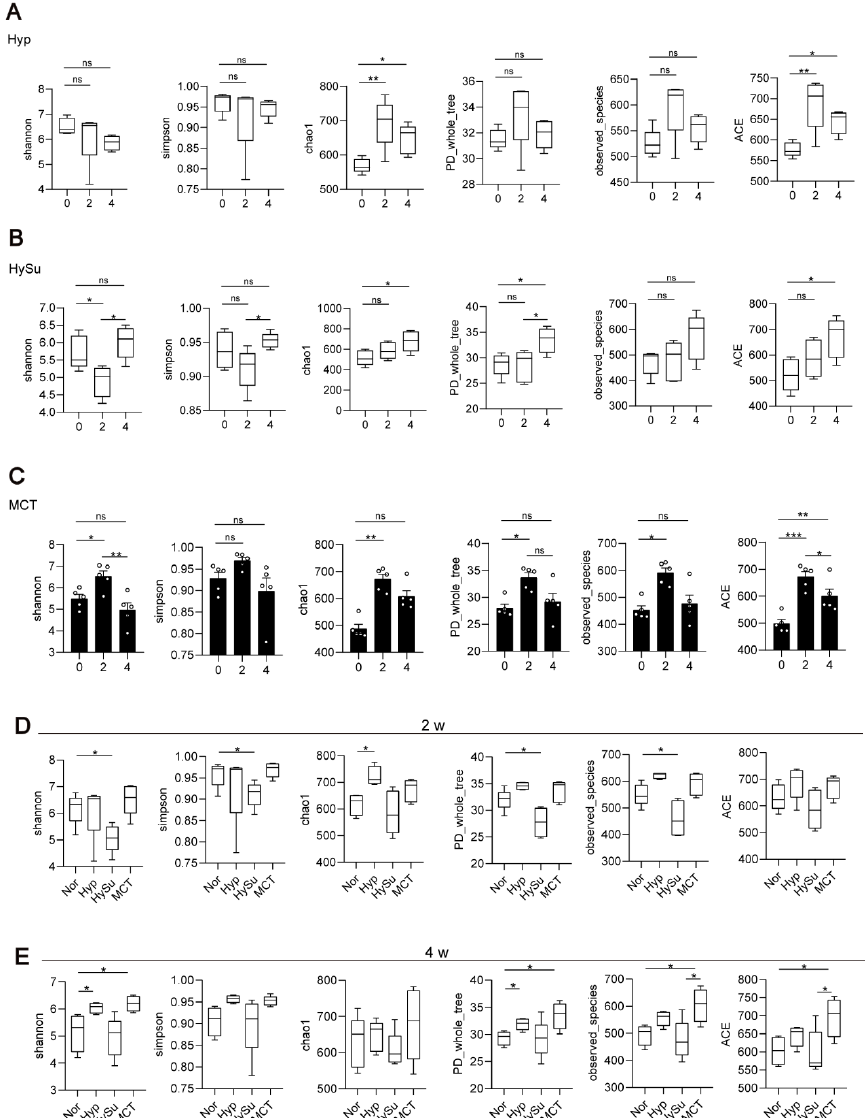
Figure 2. The dynamic α -diversity values and richness indices at week 2 and week 4 in Hyp-, HySu-, and MCT-induced PH rat models. Feces were collected from rats at weeks 0, 2, and 4. ( A – E ) The α -diversity and β -diversity of the gut microbiota in Hyp-, HySu-, and MCT-induced PH rats were measured by the Shannon, Simpson, Chao, PD whole tree, and observed species indices. Chao1 estimates the number of species, whereas Shannon estimates the effective number of species. Data are presented as the mean ± SEM of 5 animals, * p < 0.05, ** p < 0.01, *** p < 0.001, ns: no significance, and one-way ANOVA followed by Student–Newman–Keuls multiple comparison test for parametric distributions. The Kruskal–Wallis test followed by the Dunnett post hoc test were used for non- parametric distributions. Nor: normoxia group; Hyp: hypoxia-induced group; HySu: hypoxia/Sugen 5416-induced group; MCT: MCT-induced group. 0, 2, and 4 represent the week of treatment. At week 2, compared with those in the Nor group, the abundances of gut microbiota have not significantly changed (Figure S2A,B). At week 4, compared with those in the Nor group, the abundance of Firmicutes was significantly decreased, the abundances of Bacteroidetes and Tenericutes were significantly increased, and the ratio of Firmicutes/Bacteroidetes was decreased in the Hyp-induced group. The abundance of Actinobacteria was significantly increased in the MCT-induced group (Figure